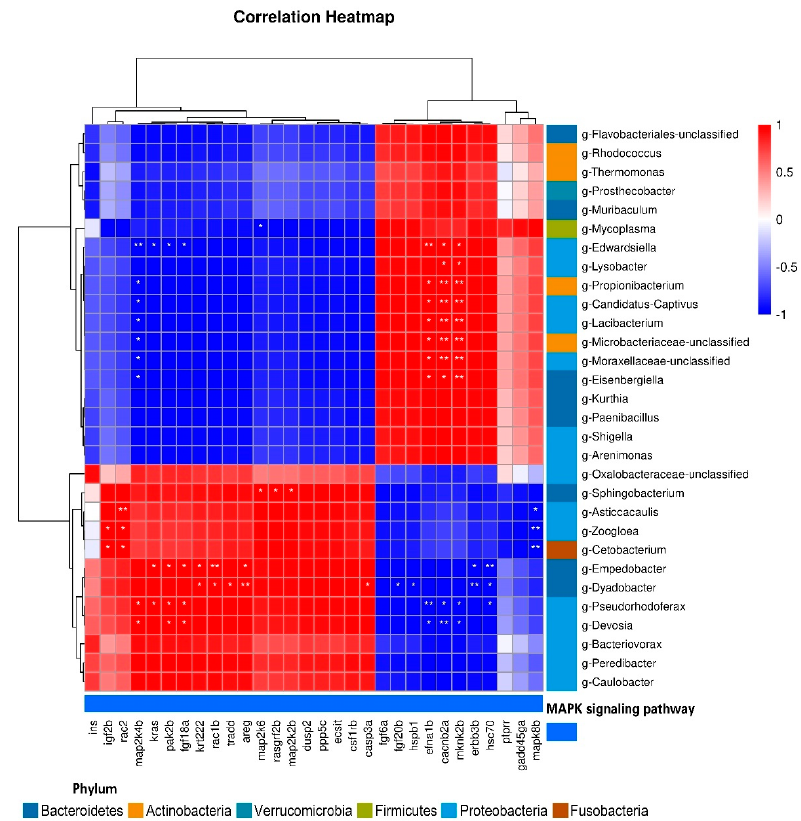
Figure 11. Correlation between DEGs and intestinal microflora at the genus level (*, p < 0.05; **, p < 0.01).